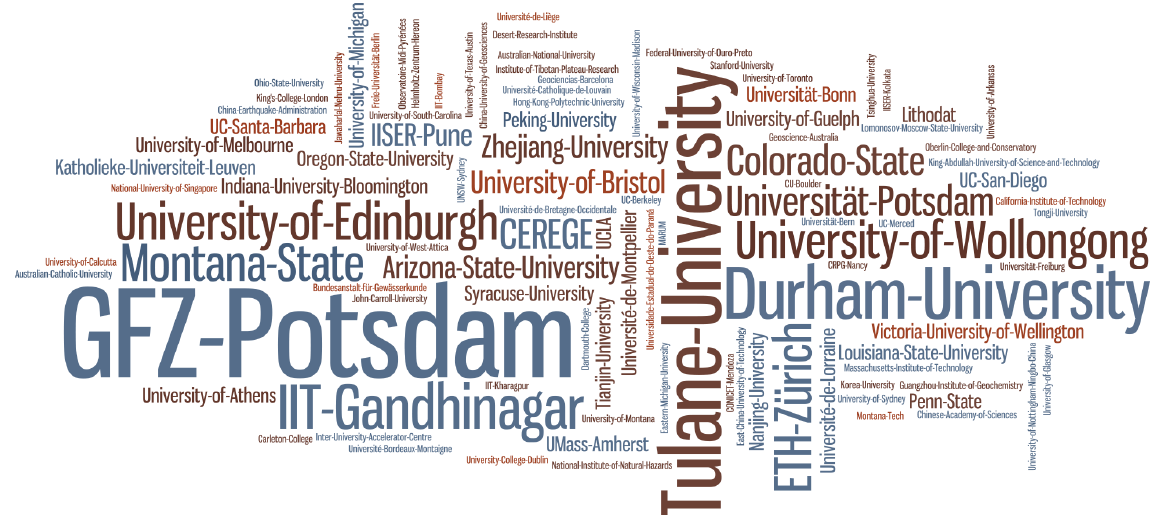
Figure 1. List of institutions whose members (researchers and students) requested data from OCTOPUS up to end of year 2021. The size of the words is proportional to the number of unique individuals requesting data from each institution, rather than the number of individual